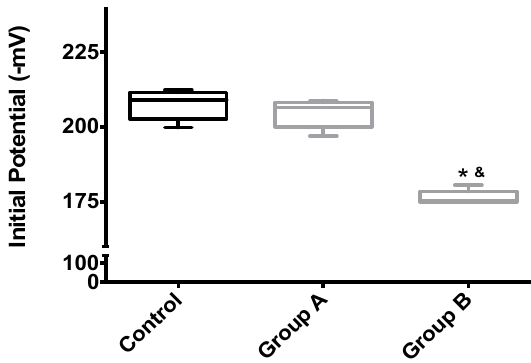
Figure 5. The effects of I/R with or without BBR (18.6 mM) supplementation on hepatic mitochondrial initial membrane potential. Mitochondria were isolated from animals sacrificed after 12 h of hepatic exposure to preservation solution and 1 h of reperfusion, as described in the Materials and Methods Section. Control animals were sham operated. Δψ was evaluated with a TPP + -sensitive electrode. Mitochondria isolated from the I/R group (Group B) had a significant loss of membrane potential compared to the control group, while the supplementation with BBR (Group A) was sufficient to prevent said alterations. Data are the means ± 5–95 percentile of at least 2 different experiments, performed with 10 animals/group. * indicates a statistically-significant difference ( p < 0.05) against the control group; & indicates a statistically-significant difference ( p < 0.05) against Group A.